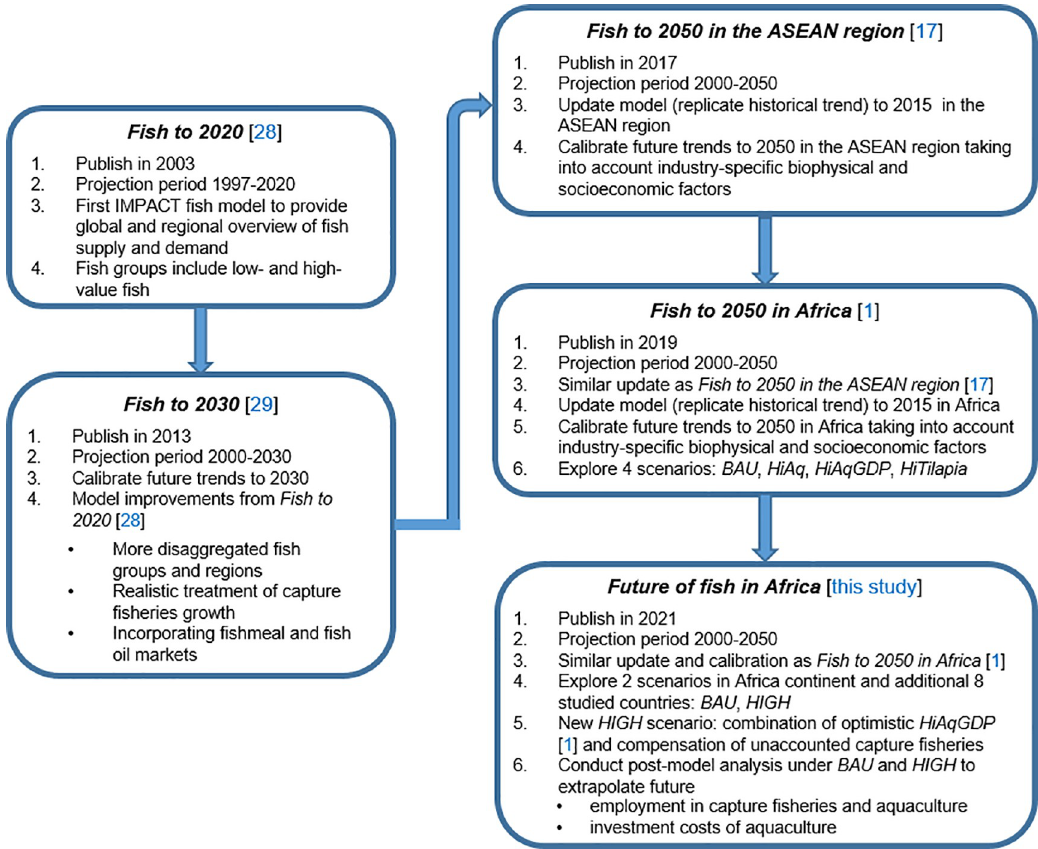
Fig 1. Chronological model improvement and analysis using IMPACT fish